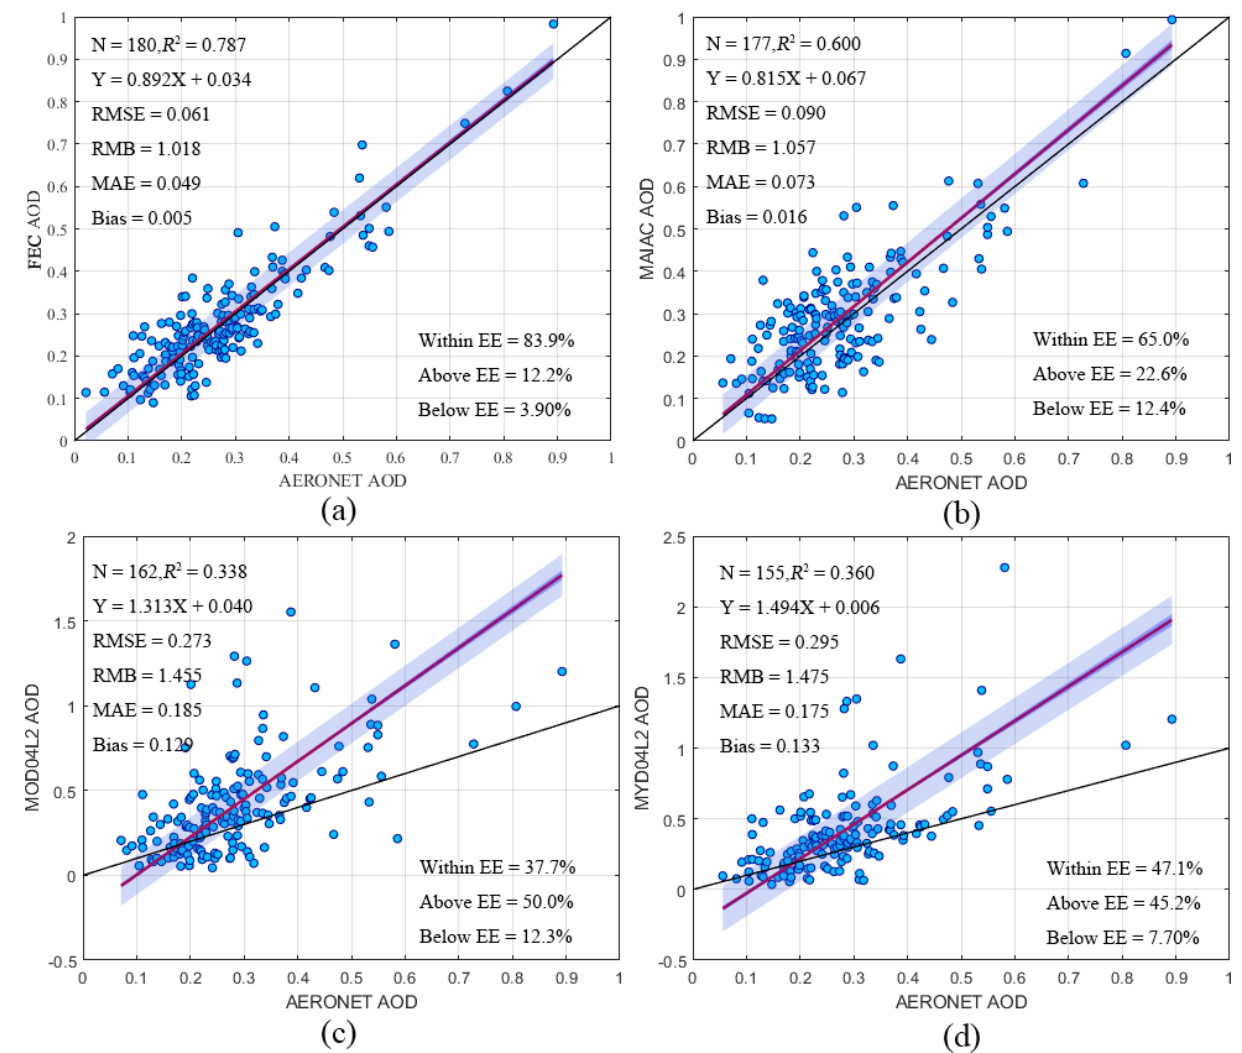
Figure 3. Comparisons of various products with the AERONET AODs: (a) FEC AODs, (b) MAIAC AODs, (c) MOD04L2 AODs, and (d) MYD04L2 AODs. The red line denotes the regression line, the black line shows the 1 : 1 line, and the blue area indicates the 95% prediction